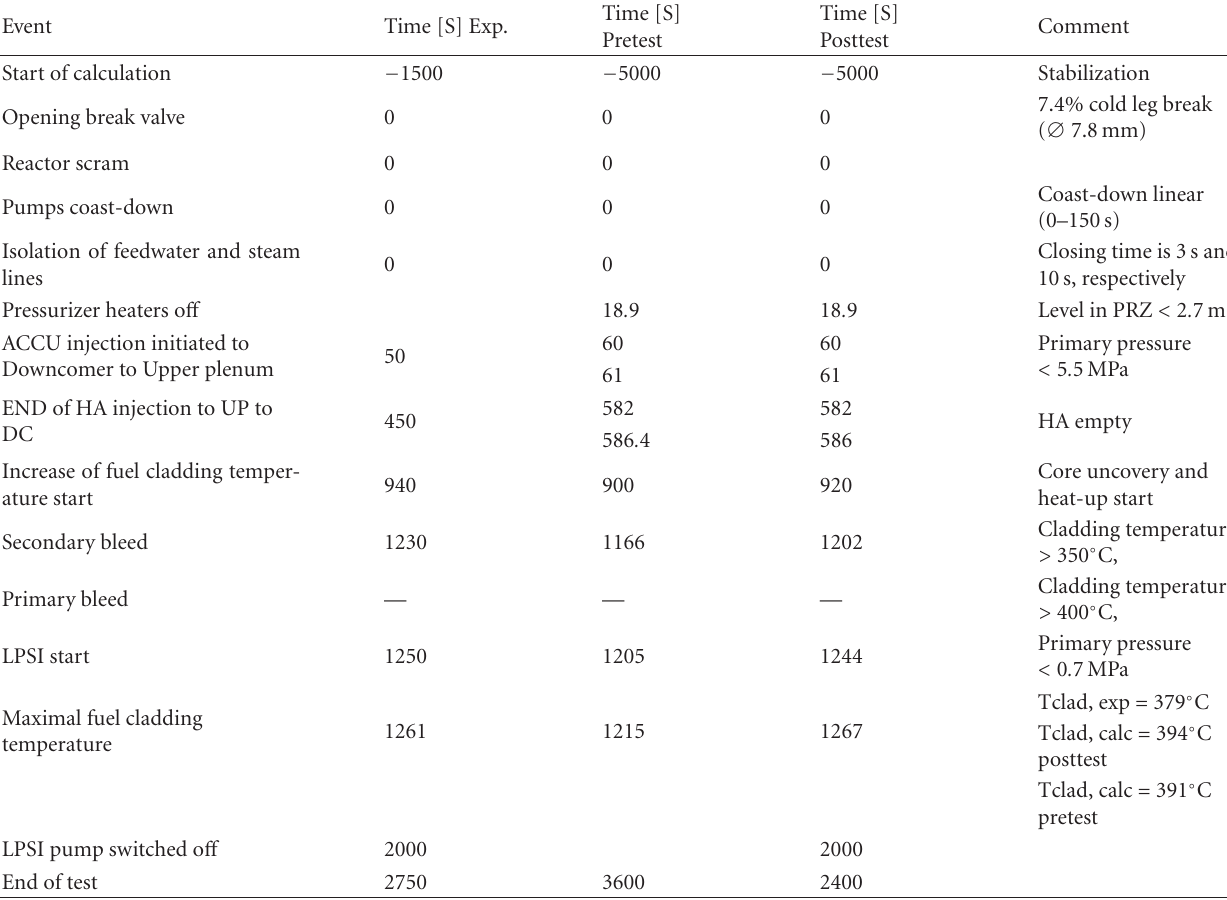
Table 1: Test T2.1: Timing of the main events, CATHARE versus